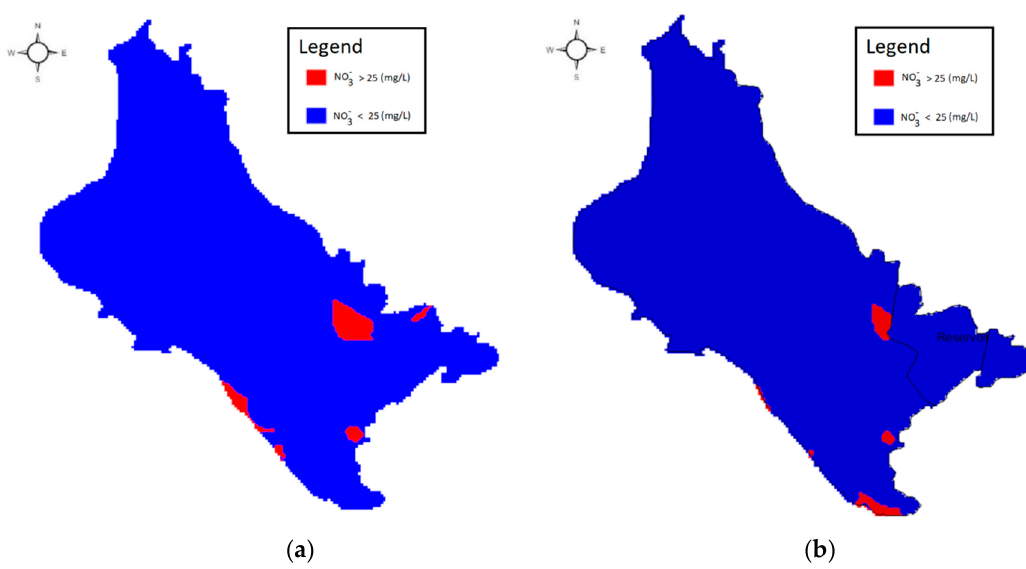
Figure 8. Spatial location of over 25 mg / L nitrate concentrations: ( a ) No-reservoir scenario and ( b ) reservoir scenario.